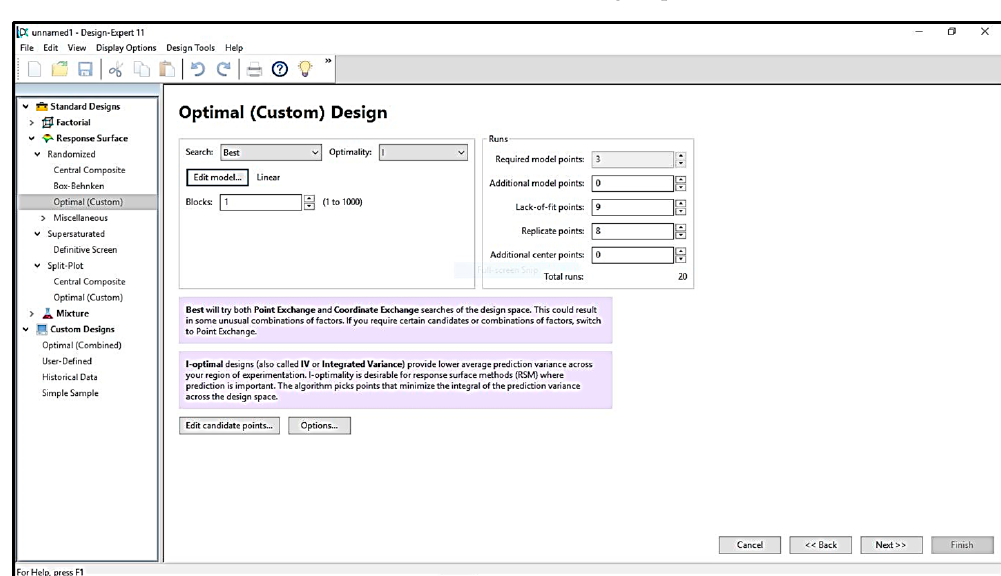
Figure 3. Determination Number of Run